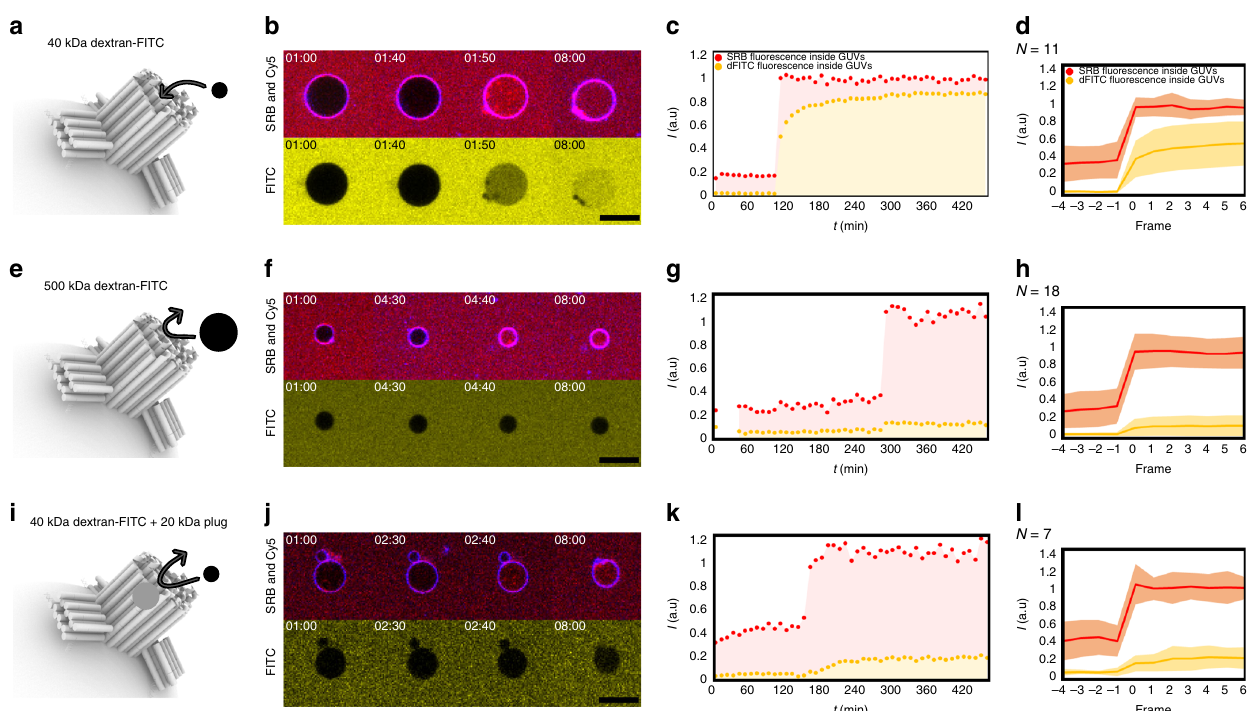
Fig. 4 GUV dye-in fl ux assay with DNA nanopores. GUV experiments of opened lipidated nanopores with SRB and 40-kDa dextran – FITC ( a – d ) or SRB and 500-kDa dextran – FITC in outer solution ( e – h ). i – l GUV experiments with SRB and 40-kDa dextran – FITC in outer solution together with DNA nanopores containing 20-kDa PEG moieties immobilized in the inner channel as a size-selective plug. a , e , i Schematic of DNA nanopores penetrating lipid bilayer. b , f , j Time series of confocal images at the given intervals (hh:mm) of SRB (red), Cy5-labeled DNA nanopores (blue), and FITC (yellow). ( c , g , k ) Single traces of fl uorescent signal from the inside of GUVs from t = 00:00 to t = 08:00 (hh:mm). d , h , l Average fl uorescent traces of in fl ux-normalized events for N -recorded events. All recorded rapid SRB in fl ux events are included and data found in Supplementary Tables 2 – 4. The shaded regions surrounding the lines illustrate the standard deviations from the traces. Scale bars in ( b , f , j ) are 10 µ